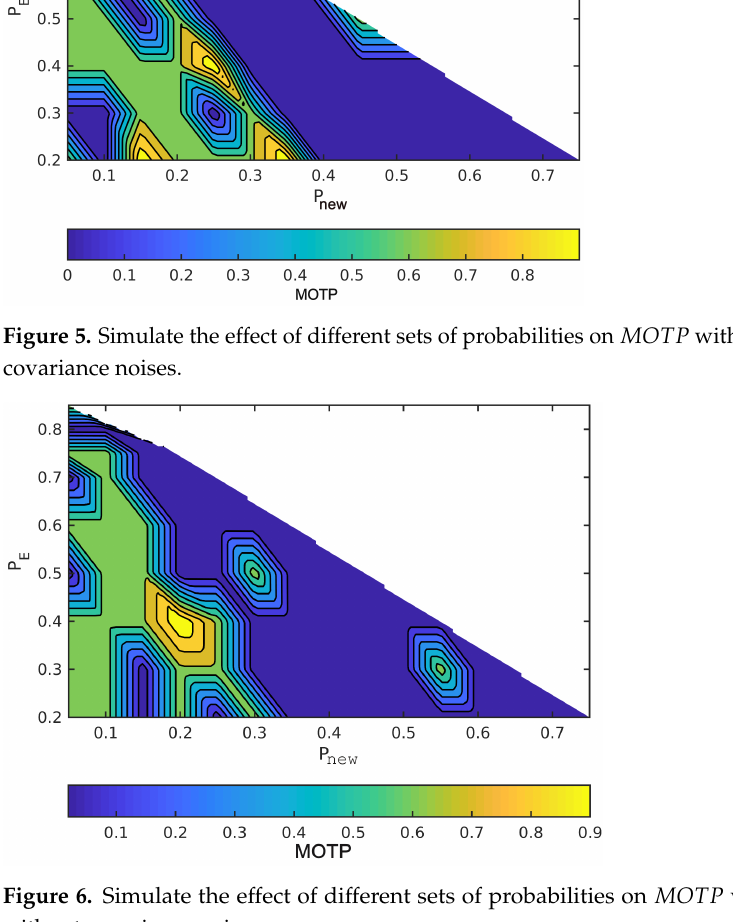
Figure 6. Simulate the effect of different sets of probabilities on MOTP with dynamic VRUs and without covariance